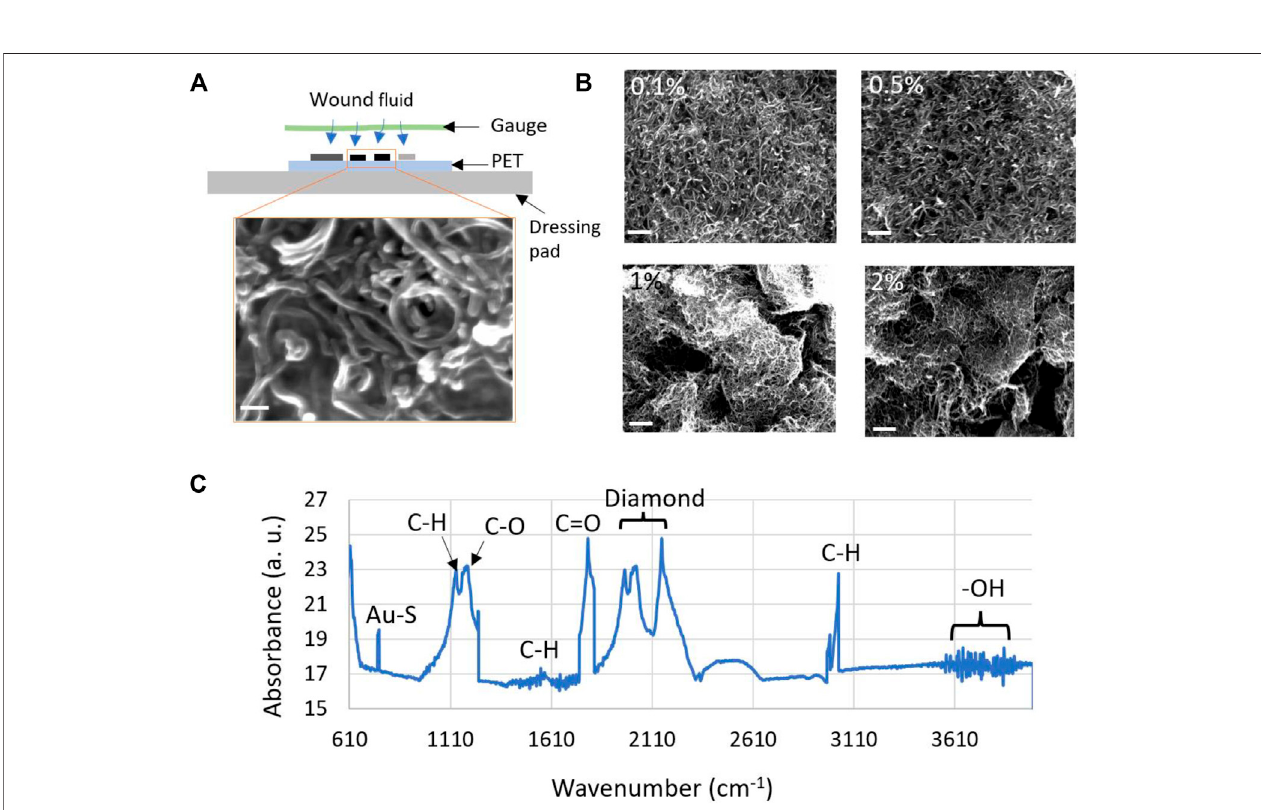
Frontiers in Nanotechnology |